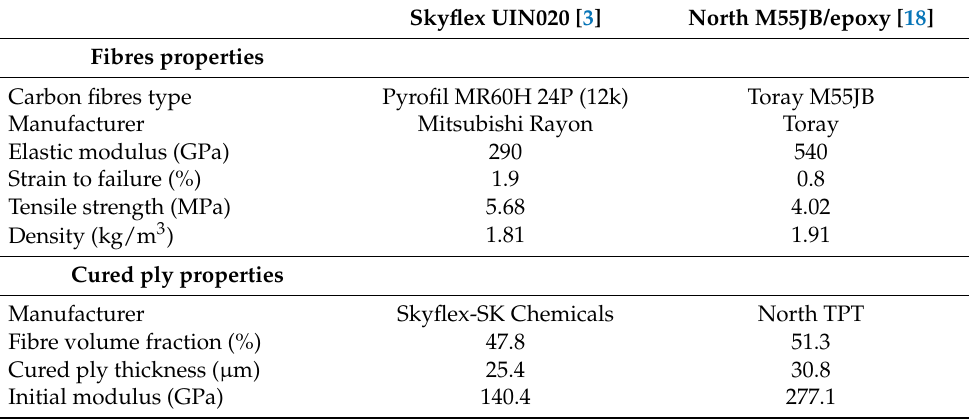
Table 1. Fibres and cured plies main